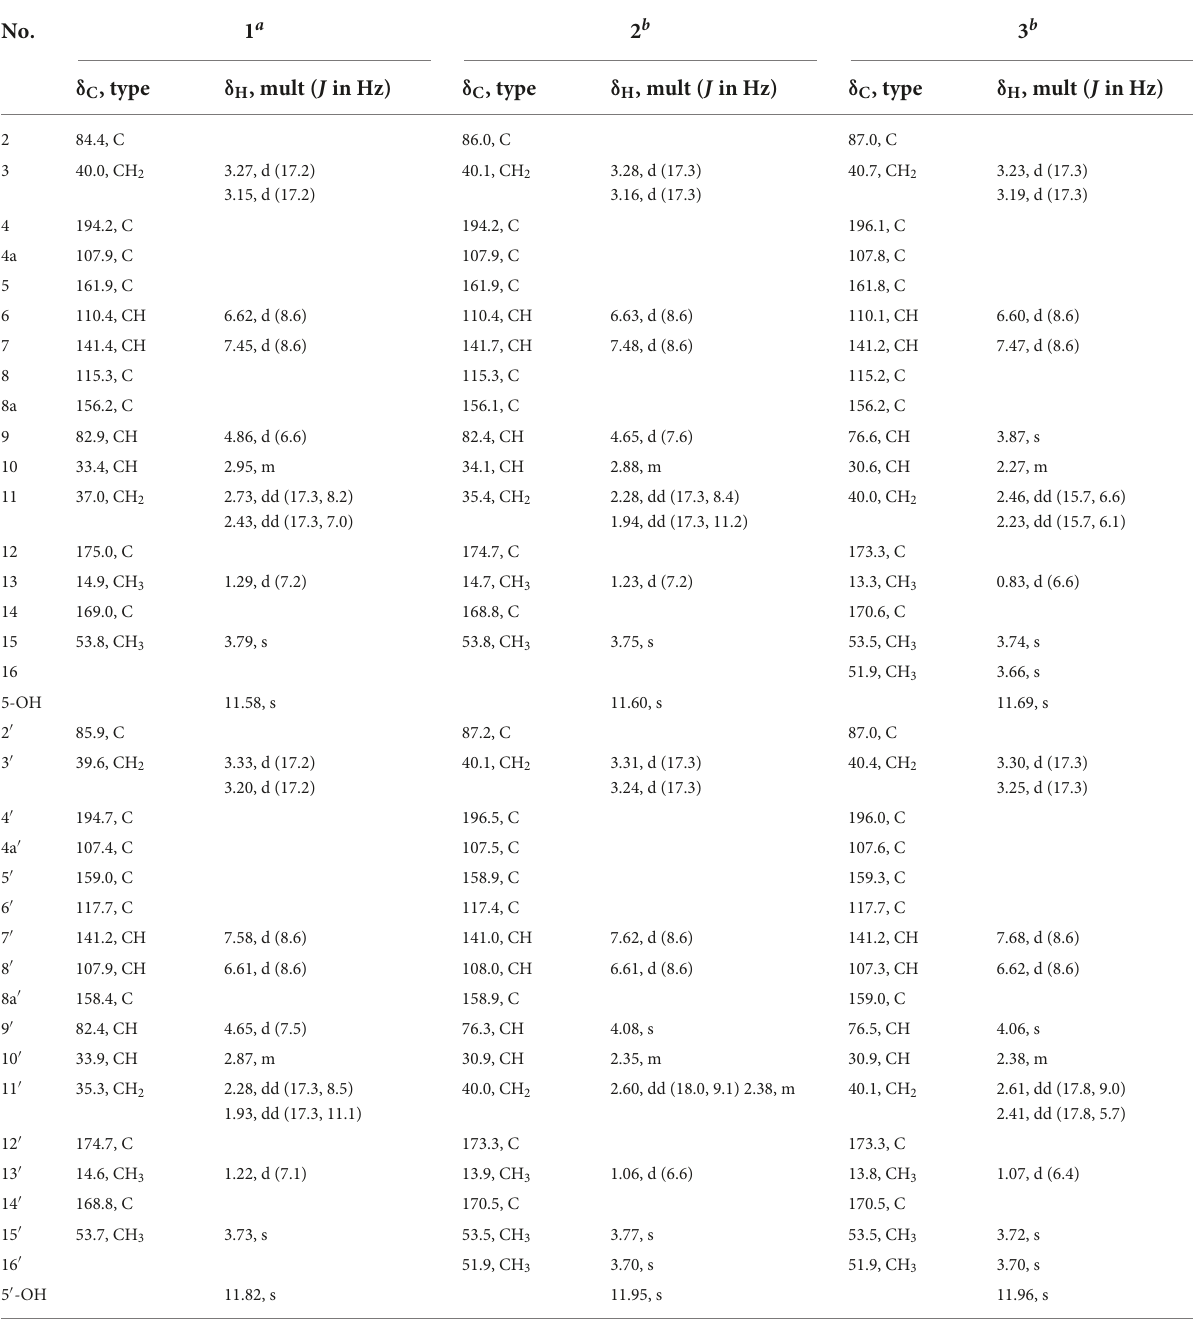
TABLE 1 1 H and 13 C NMR spectroscopic data of Compounds 1 – 3 (CDCl 3 ).